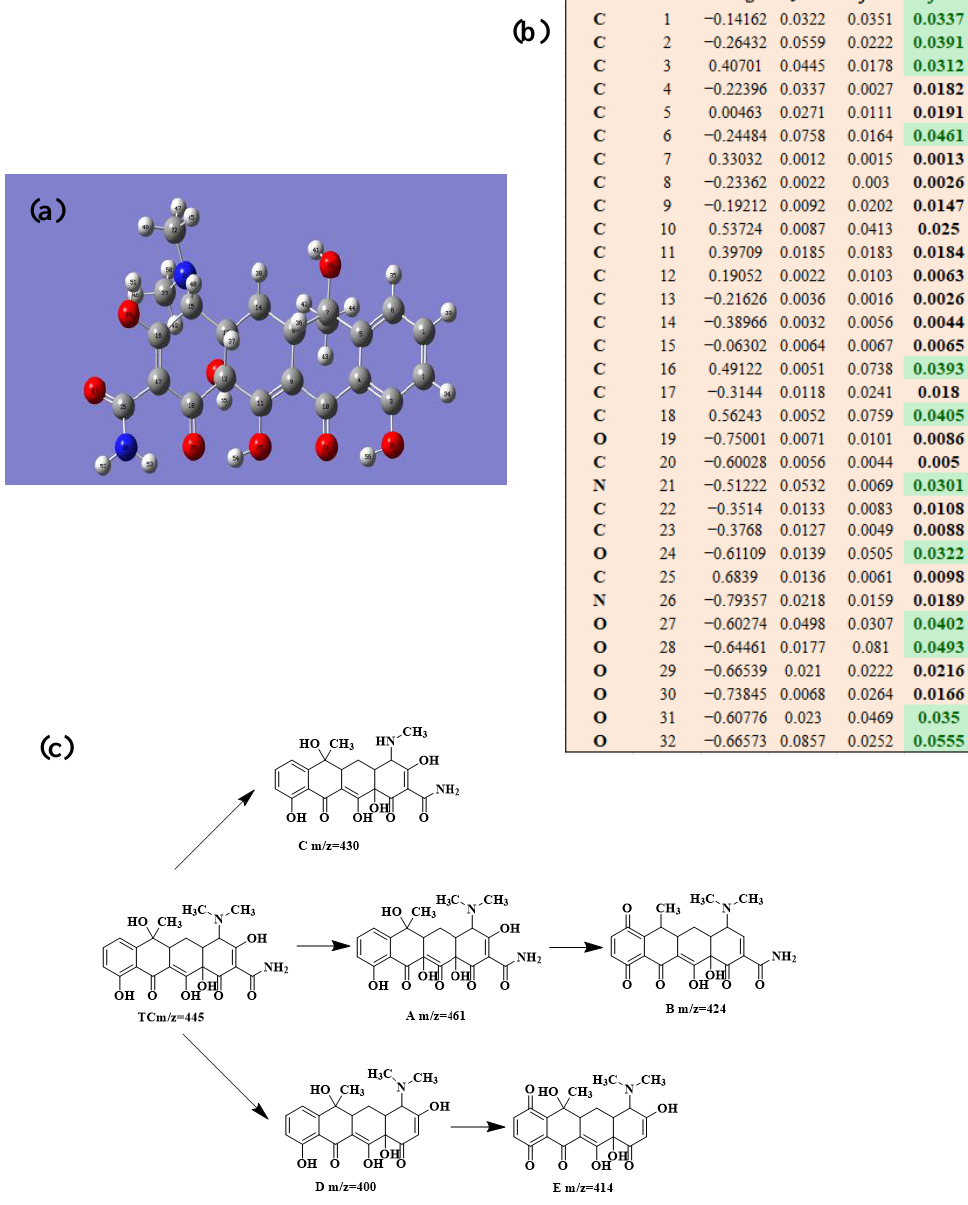
Figure 8. ( a ) Chemical structure, ( b ) NPA charge distribution and Fukui index ( f 0 ) and ( c ) degradation pathway of TC.